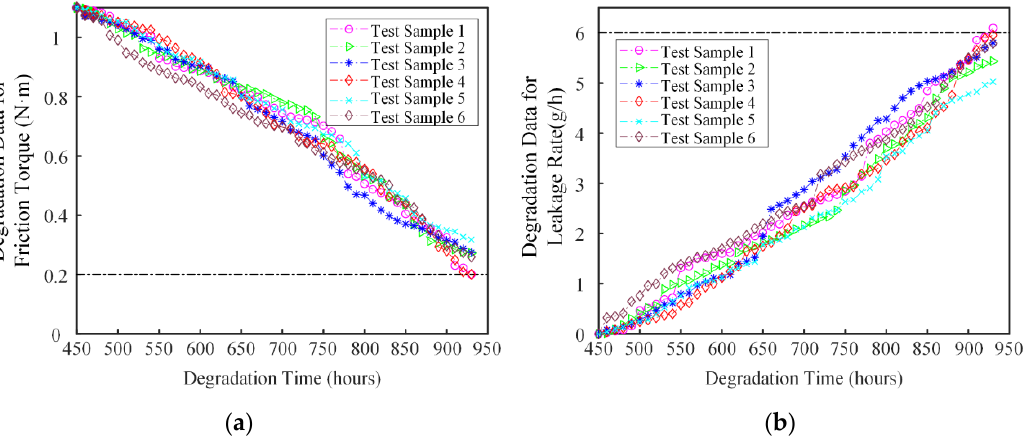
Figure 12. Degradation paths of two performance indicators for mechanical seals. ( a ) Degradation path for friction torque; ( b ) Degradation path for leakage rate